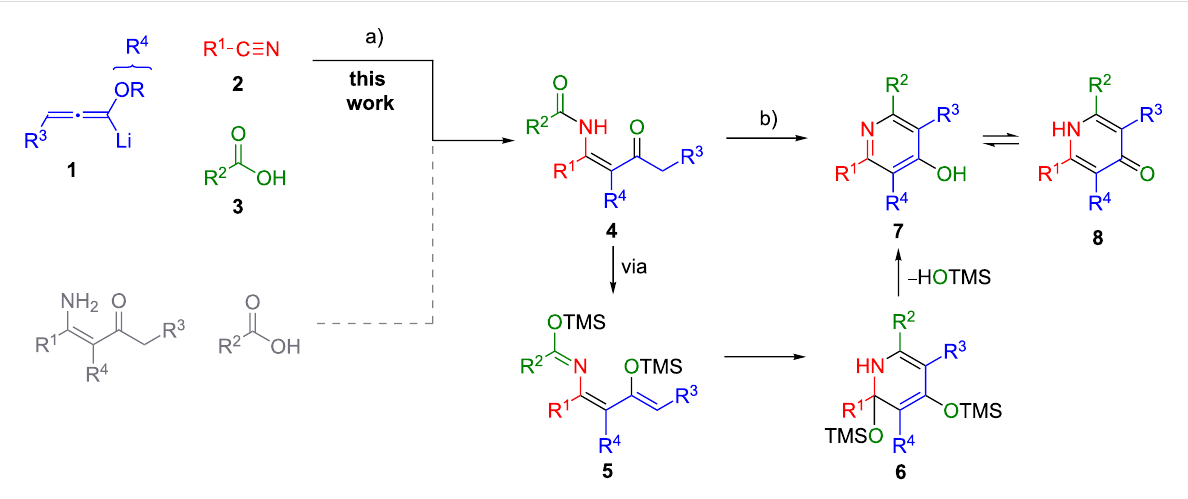
Scheme 1: Preparation of β -ketoenamides and subsequent cyclocondensation to 4-hydroxypyridines. a) Et 2 O, − 40 °C to r.t. 16 h, b) TMSOTf, NEt 3 , CH 2 Cl 2 or ClCH 2 CH 2 Cl